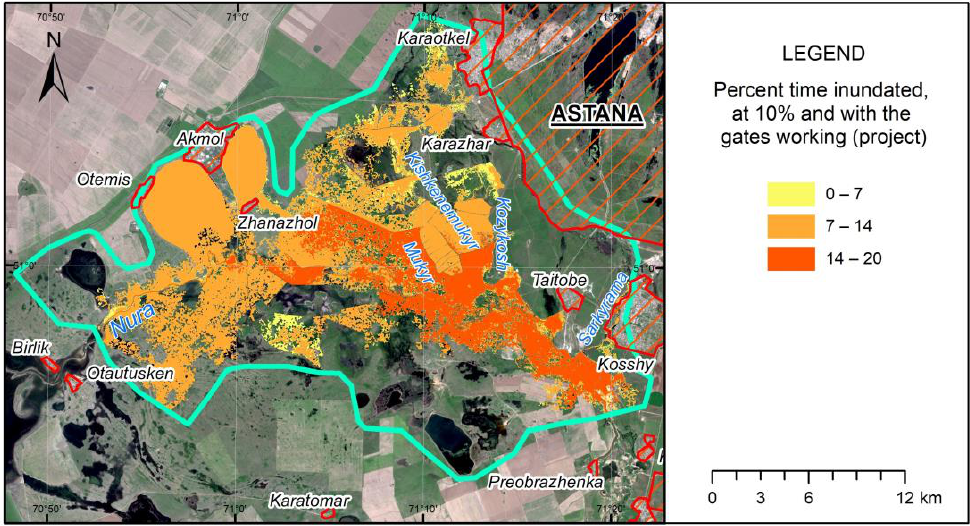
Figure 15. Flood duration map of the 2019 flood hydrograph simulated on DEM with changes (project scenario). Table 7. Flood duration of different scenarios simulated on modified